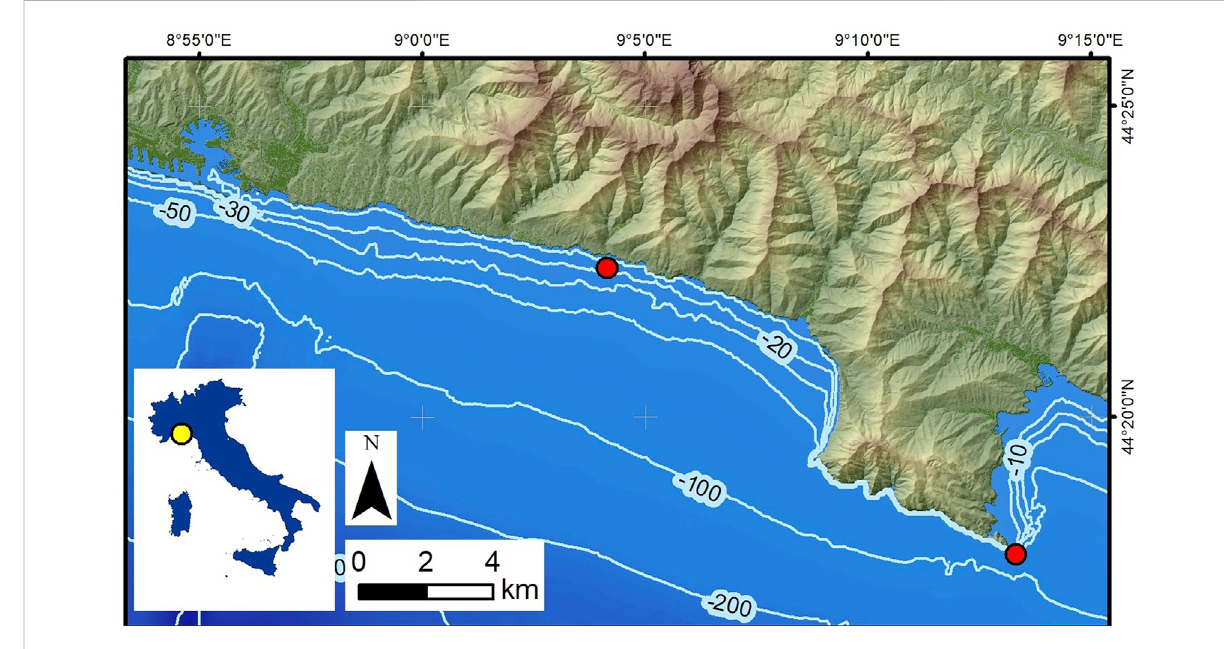
FIGURE 1 Locations of the two sampled sites (red circles). Porto fi no is bottom right, and Bogliasco is in the